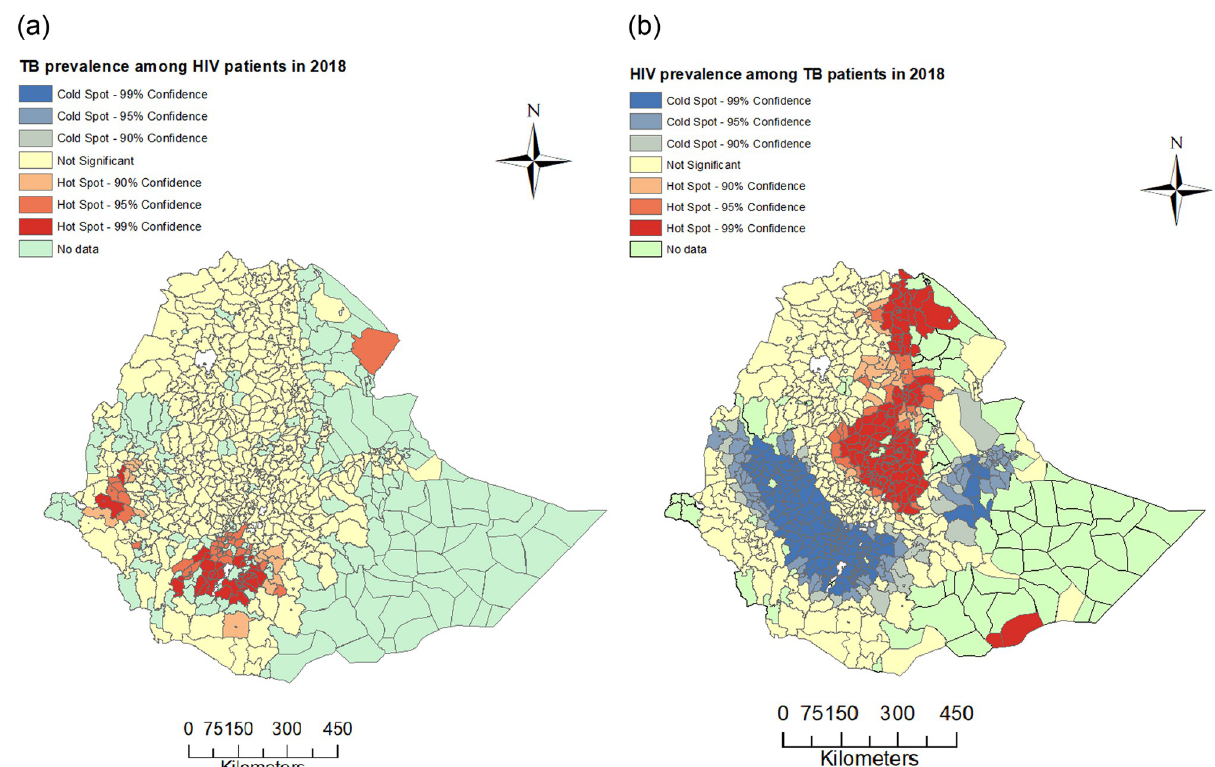
Fig 3. Spatial clustering plot. Spatial clustering for prevalence of TB among PLHIV (panel a) and HIV among TB patients (panel b) in Ethiopia at district level in 2018 using the Getis-Ord G � statistic. i